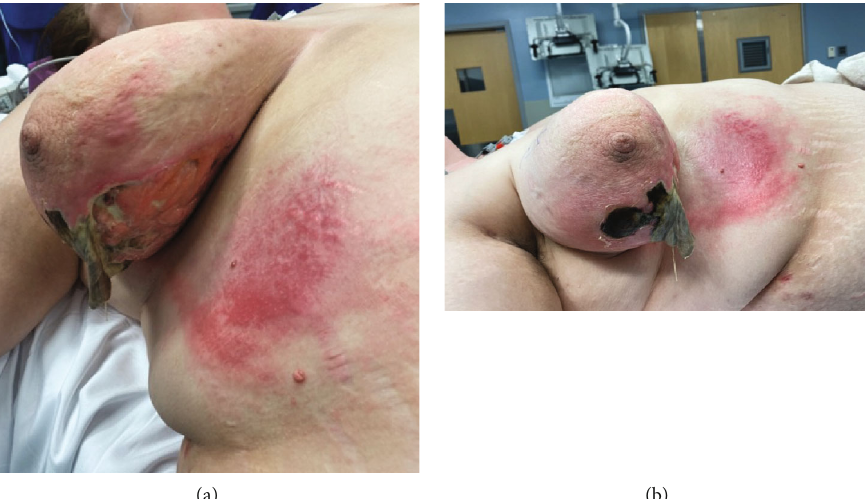
Figure 1: (a) Open right breast necrotic wound, with skin sloughing. (b) Erythema extending from the areolar complex to the superior aspect of the right anterior abdominal